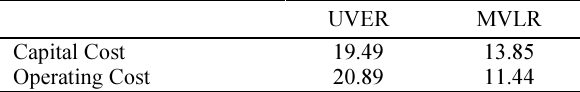
Table 8. The MAER obtained from the UVER and MVLR